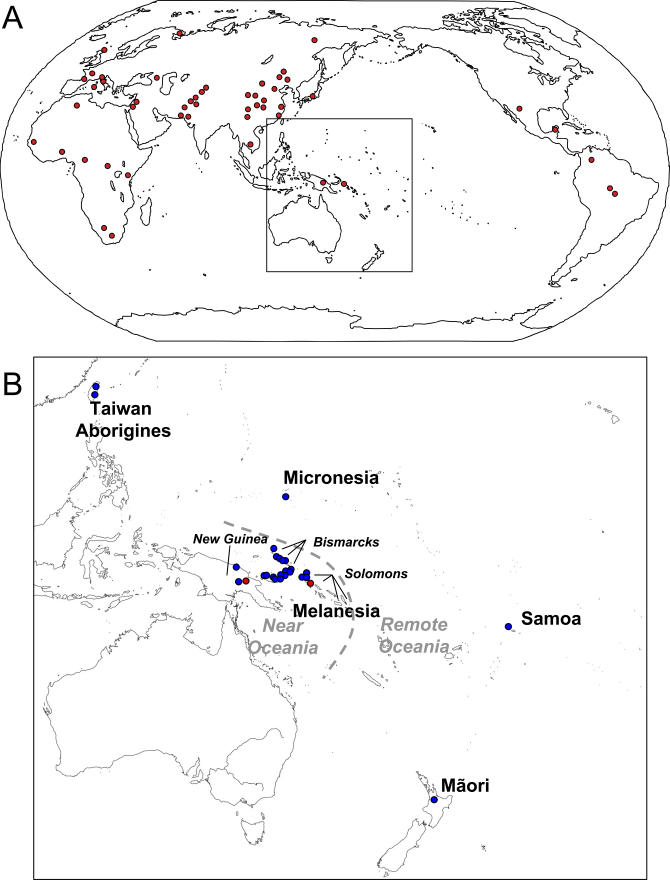
Populations Included in This Study(A) HGDP-CEPH population locations. The two Pacific groups are boxed.(B) Pacific population locations. Our population samples are blue; the 2 HGDP-CEPH Melanesian “Oceanic” groups are red.